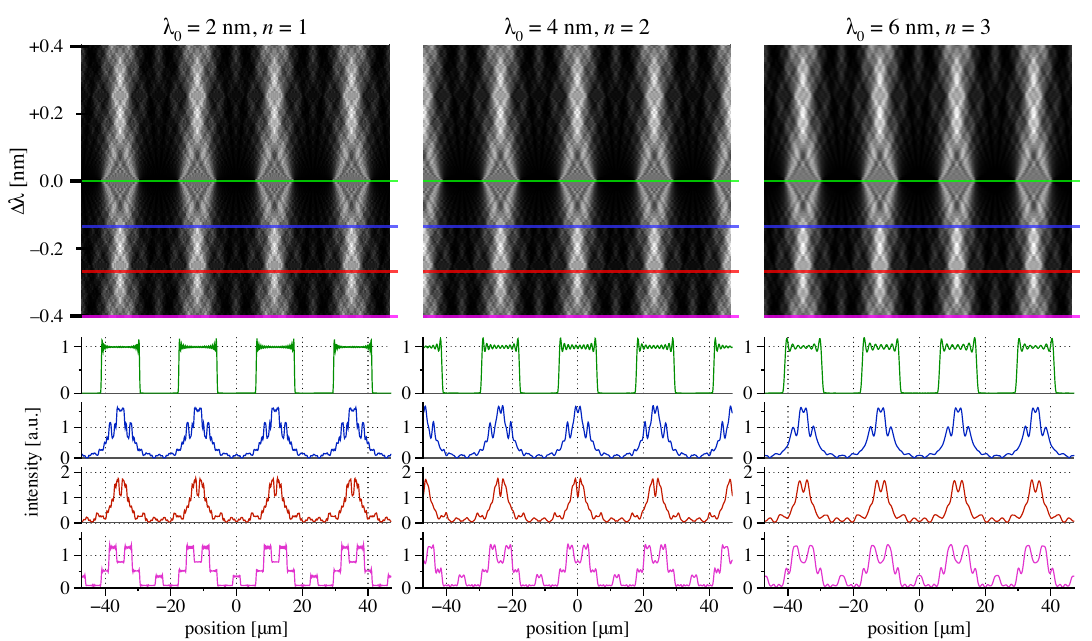
Figure 5. Coherent wave-propagation calculations of the detector-plane, central intensity region in shearing interferometry, for a 2, 4, and 6nm wavelength, with a fixed geometry matching Figure 4a. Eighty, uniformly-illuminated grating lines are modeled in each case. Conditions match the first three Talbot planes, respectively. Each row is normalized for constant integrated power. Green lines indicate the Talbot condition. Blue, red, and magenta lines show wavelength shifts of − 0.133nm, − 0.267nm, and − 0.400nm, respectively. Corresponding intensity profiles are extracted from the wavelength offsets and plotted